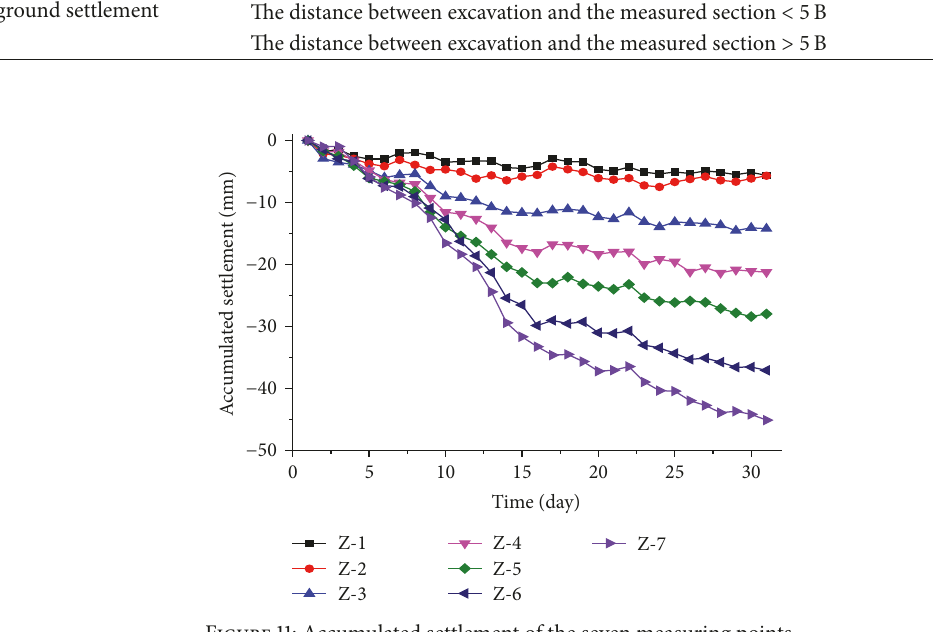
Figure 11: Accumulated settlement of the seven measuring